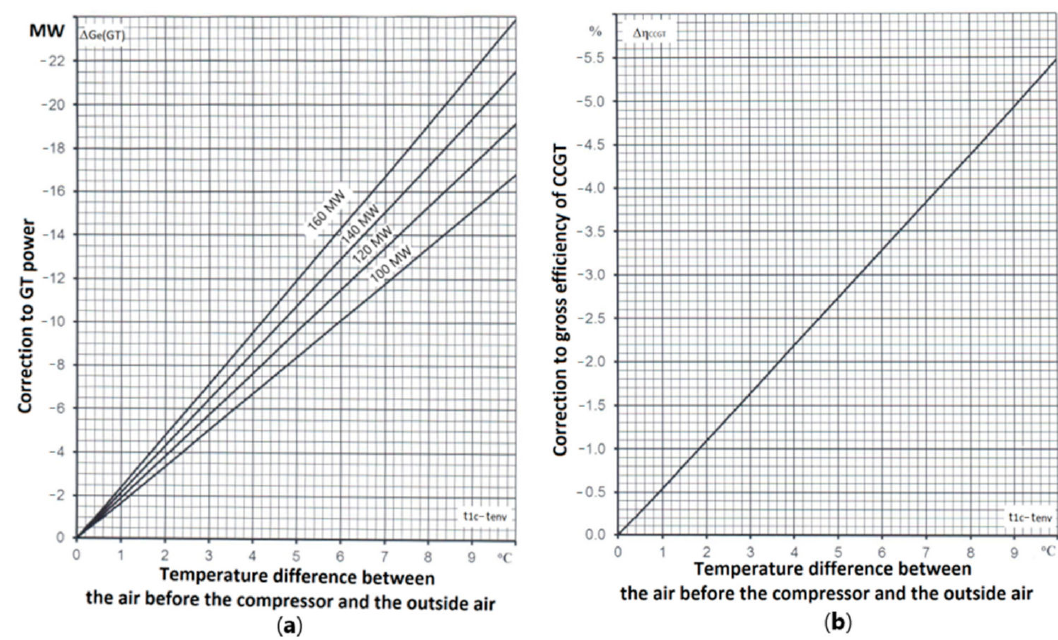
Figure 4. Corrections graphs for the inclusion of the anti-icing system (AIS): ( a ) correction to GT power; ( b ) correction to gross efficiency of the CCGT-450